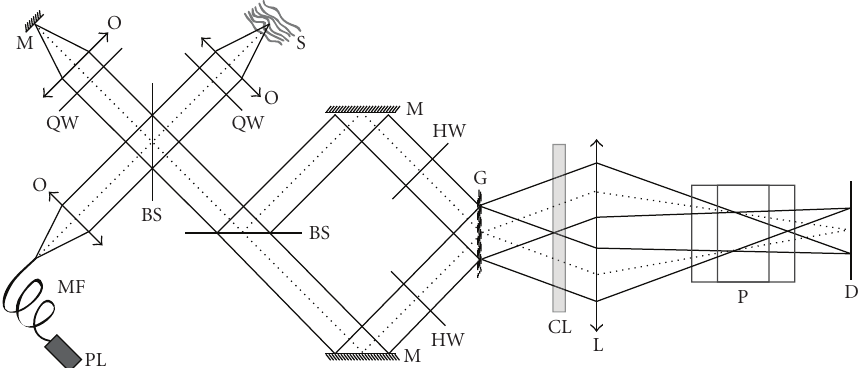
Figure 1: Setup for optical spectrotomography: M: mirrors; BS: polarizing beam-splitter cube; QW: quarter wave plate; HW: half-wave plate; L: spherical lens; CL: cylindrical lens; PL: supercontinuum light source; D: CCD detector; G: transmission di ff raction grating 528 gr/mm; P: removable direct vision prism; O: microscope objectives (4 × magnification); S: sample.